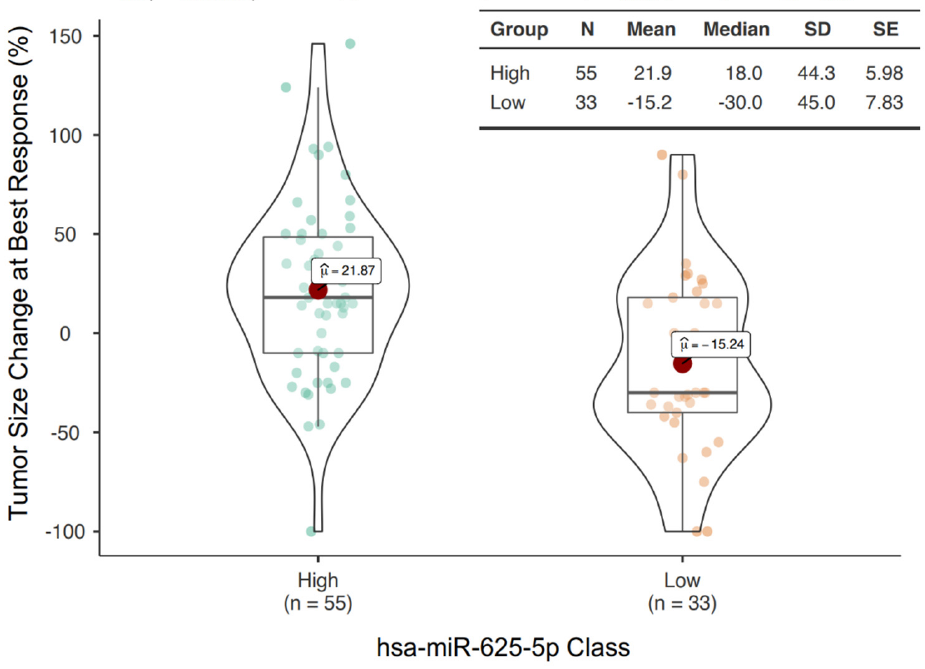
8 of 16 Figure 1. Di ff erential EV − miRNAs’ expression based on the Objective Response. Volcano Plot shows miRNAs significantly overexpressed on the right (red dots) and miRNAs significantly downregulated on the left (blue dots) ( A ). Scatter plot representing the correlation between miR − 625 − 5p levels and tumor size change at best response ( B ). Next, the optimal cutoff value of miR − 625 − 5p to discriminate between groups was evaluated with sensitivity and specificity analyses. A cutoff of 5.47 was selected (Figure S1A). Based on this threshold, 55 patients were classified as miR − 625 − 5p High and 33 patients were classified as miR − 625 − 5p Low. The miR − 625 − 5p Low class showed a median tumor size reduction of 30% compared to a median tumor size increase of 18% in the